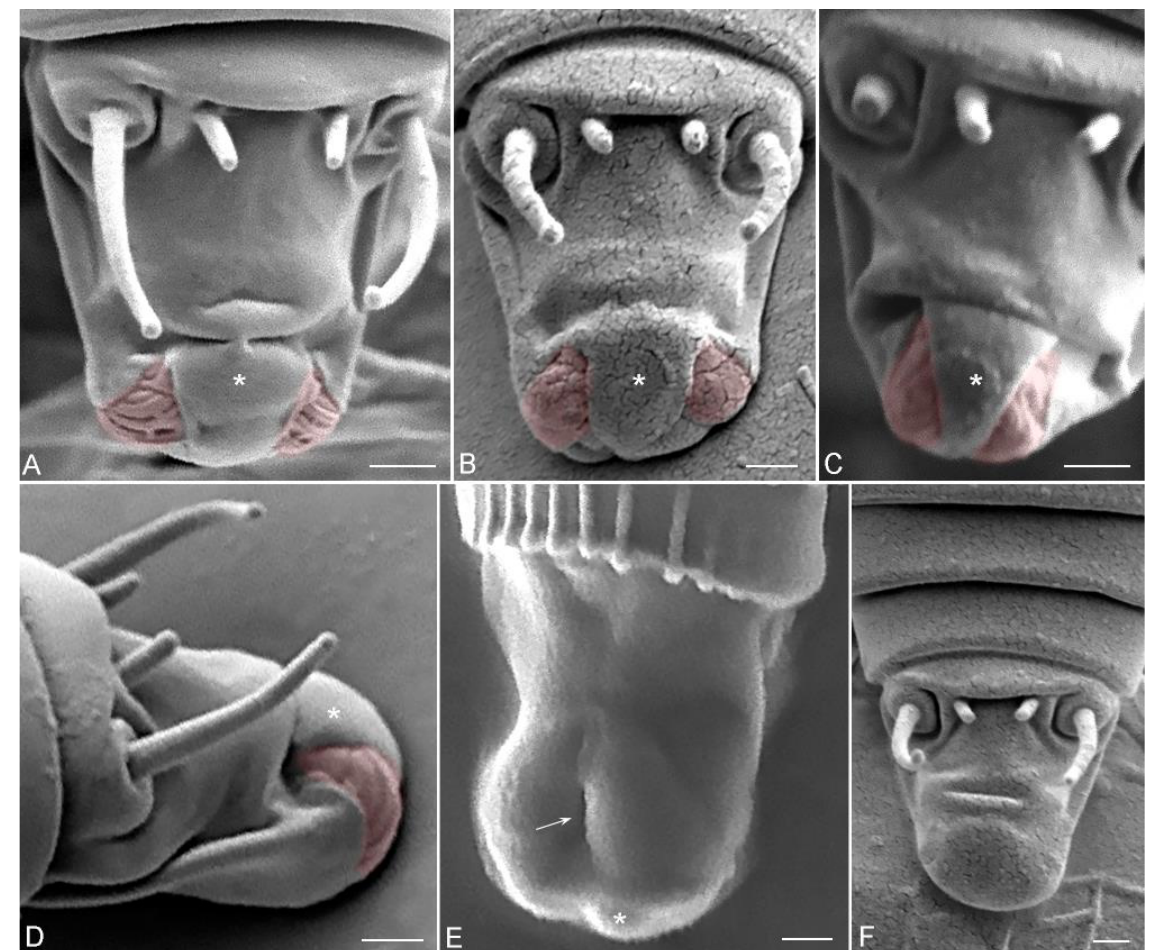
Figure 13. LT-SEM images of caudal lobes in five females ( A – E ) and male ( F ) of morphotype A of Aberoptus schotiae n. sp. ( A , B , C , F ) — dorsal view; ( D ) — lateral view; ( E ) — ventral view, arrow indicates putative anal opening. Asterisks indicate cuticular flap. Areas of porose cuticle (the spinneret) colored red. Scale bars = 1 µm.